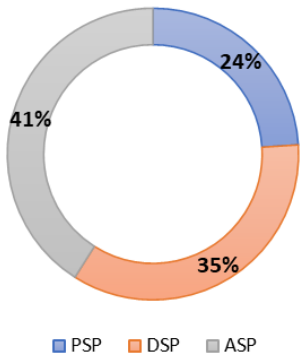
Figure 6. Toxic HABs events, distributed by syndrome: PSP, DSP and